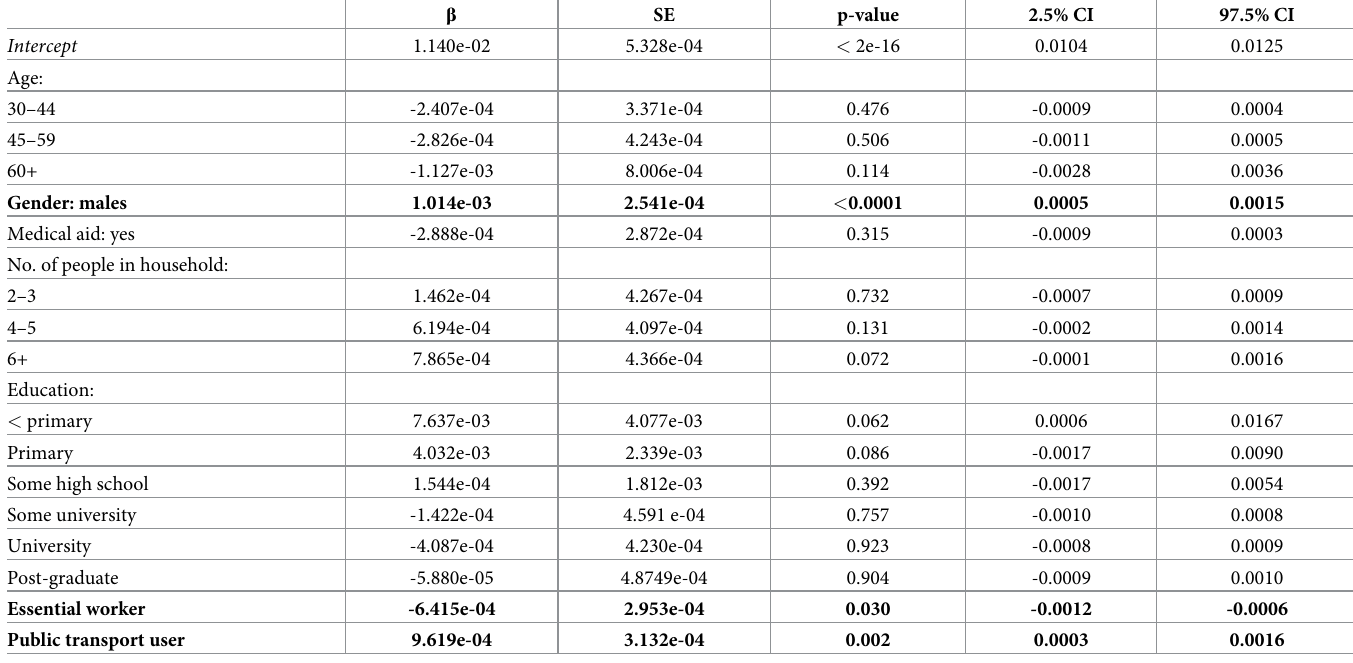
Table 3. Summary of parameter estimates ( β ), standard error (SE), confidence intervals (CI) and p value for the best performing